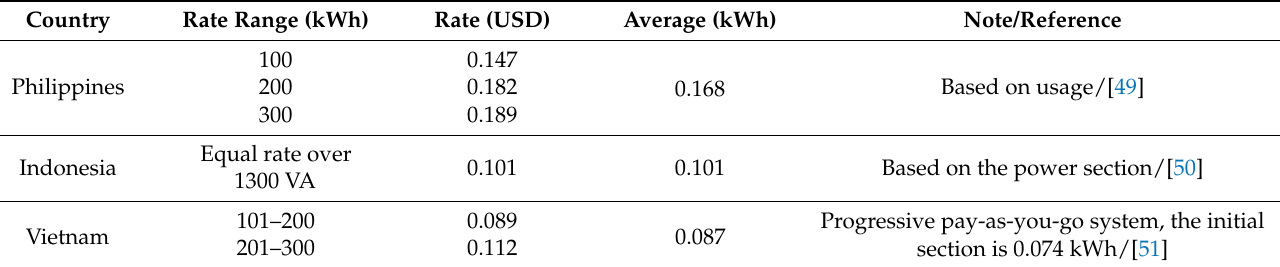
Table 14. Average electricity rates in the three countries.